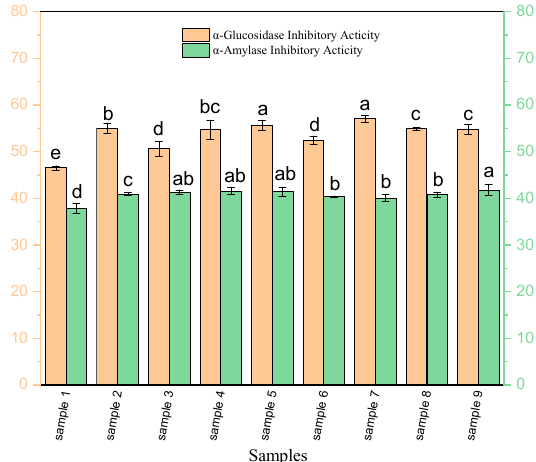
Figure 3. Overall α -amylase- and α -glucosidase-inhibitory activity (%) of OSPH under different conditions. Data are mean ± SD of three replications and the values for each activity with different letter are significantly different ( p < 0.05).